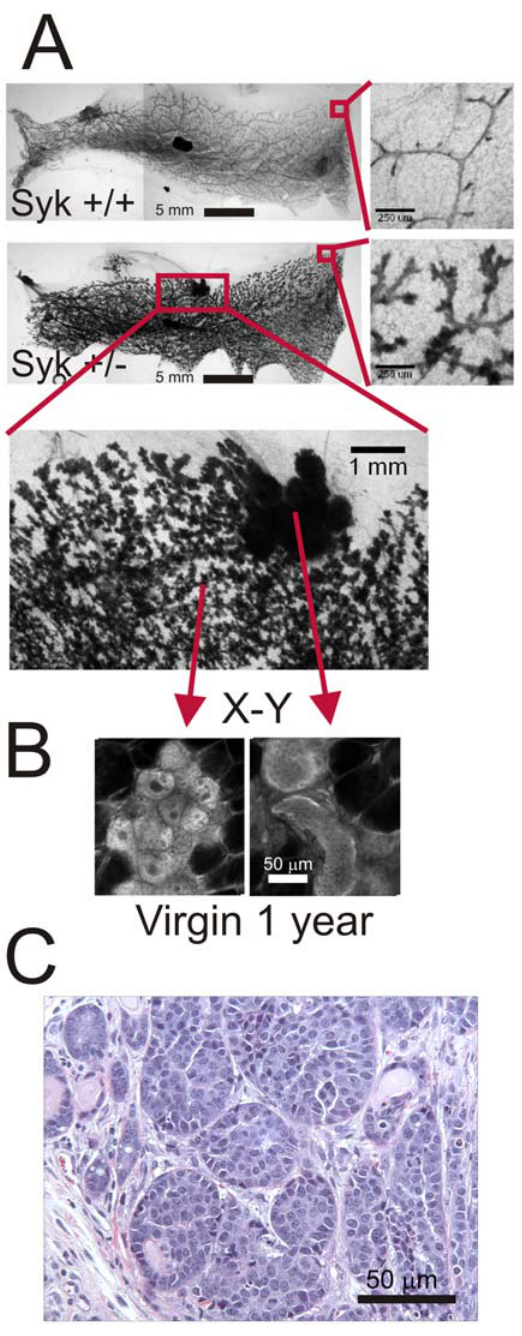
Figure 7. Heterozygous Syk + / 2 mice develop mammary gland hyperplasia and ductal carcinoma. (A) At one year in virgin females, 4 th inguinal mammary glands reveal a denser epithelial network in heterozygote compared to wild type glands. Insets at right are higher magnification views of the distal ductal tree. An area of hyperplasia in the heterozygote gland (Syk + / 2 ) indicated by a red box is enlarged. Scale bars correspond to 5 mm and 250 m m insets at right and 1 mm inset below. (B) Multiphoton imaging of carmine red autofluorescence in whole mounts of the Syk + / 2 gland revealed that the branching epithelium is over developed but lumens are visible (X-Y, inset at left). The hyperplastic portion contains no lumens (X-Y, inset at right). Scale bars correspond to 50 m m. (C) Hemotoxylin/eosin stained paraffin section from an invasive ductal carcinoma taken from a one year, virgin female Syk + / 2 . Scale bar is 50 m